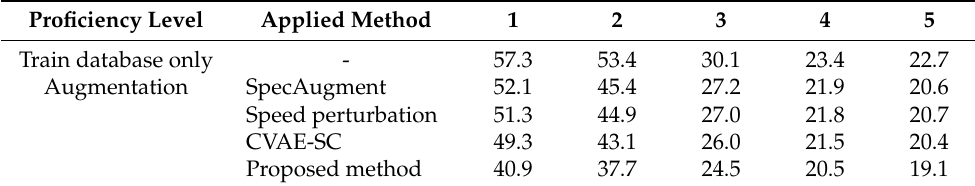
Table 5. Speech augmentation and word error rate (%) results.